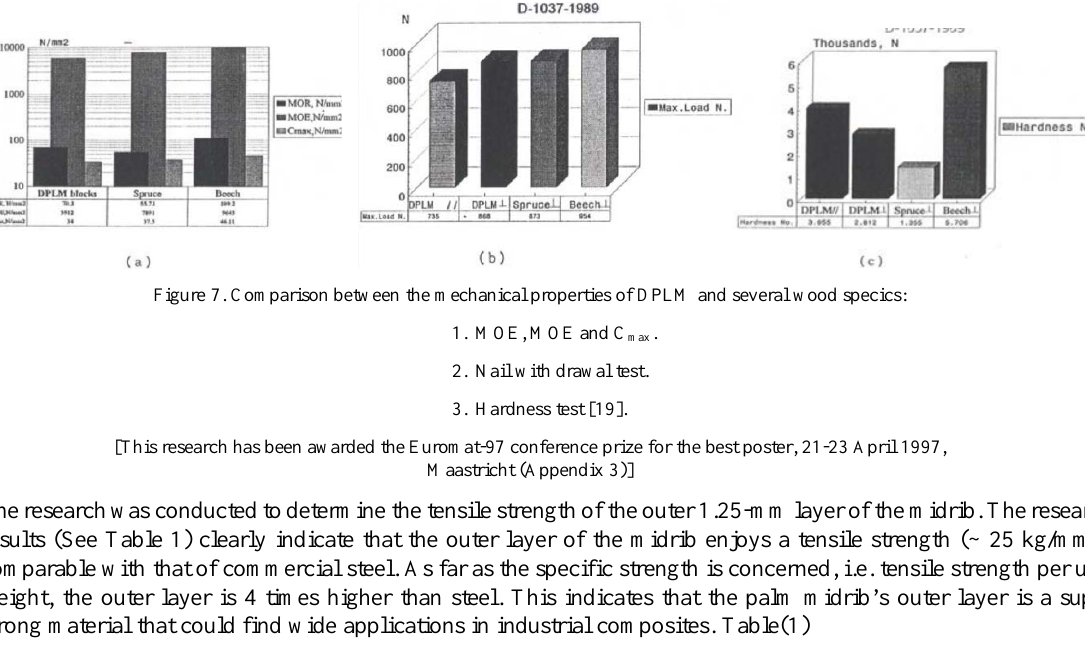
Table 1.The values of tensile strength and specific tensile strength for palm midrib outer layer, compared with several wood species and